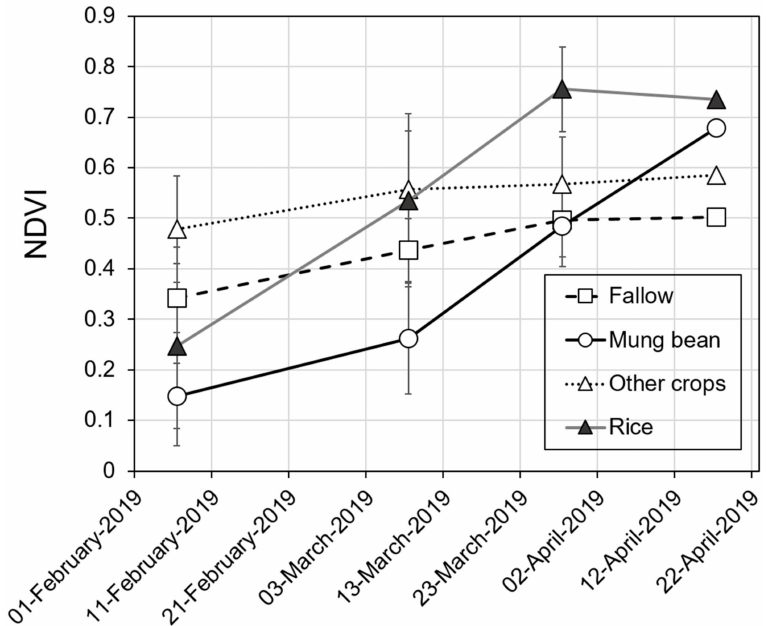
Figure 6. Time course of mean normalized di ff erence vegetation (NDVI) development of the four major crop types during the mung bean growing season from February 6 through April 27 of 2019 in Barisal division of coastal Bangladesh. Data were derived from the segments of the in situ data set created for the crop classification. Bars represent one standard